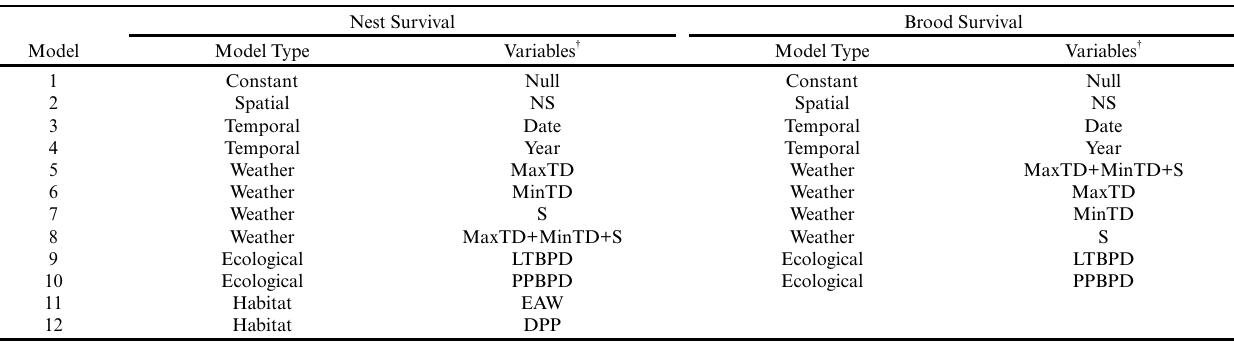
Table 2. A priori models used to estimate incubation and brooding period survival for Interior Least Tern and Piping Plover nests and broods within the AHR, 2001–2015. Variables included nest site (NS), Interior Least Tern and Piping Plover breeding pair density (LTBPD and PPBPD, respectively), initiation date (Date), year, standard deviations from average maximum temperature (MaxTD), standard deviations from average minimum temperature (MinTD), storm events (S), elevation above water (EAW), and distance to predator perch (DPP).